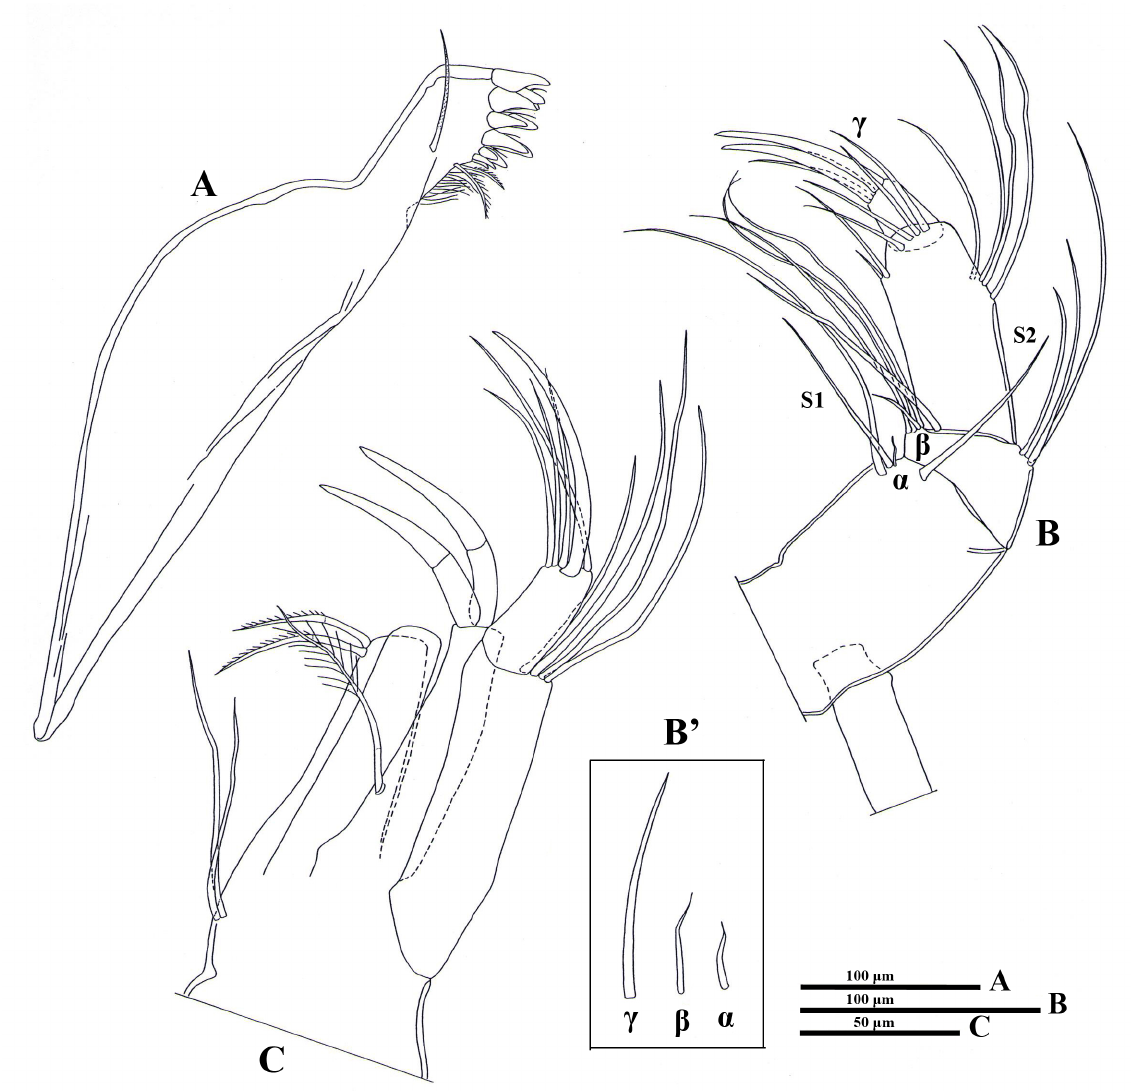
Fig. 5. Martensina thailandica gen. et sp. nov., holotype, ♂ (MSU-ZOC.317). A . Md-coxa. B . Md-palp. B’ . Md-palp, α, β, γ setae. C . Mx1. Scale bars: A–B = 100 μm; C = 50